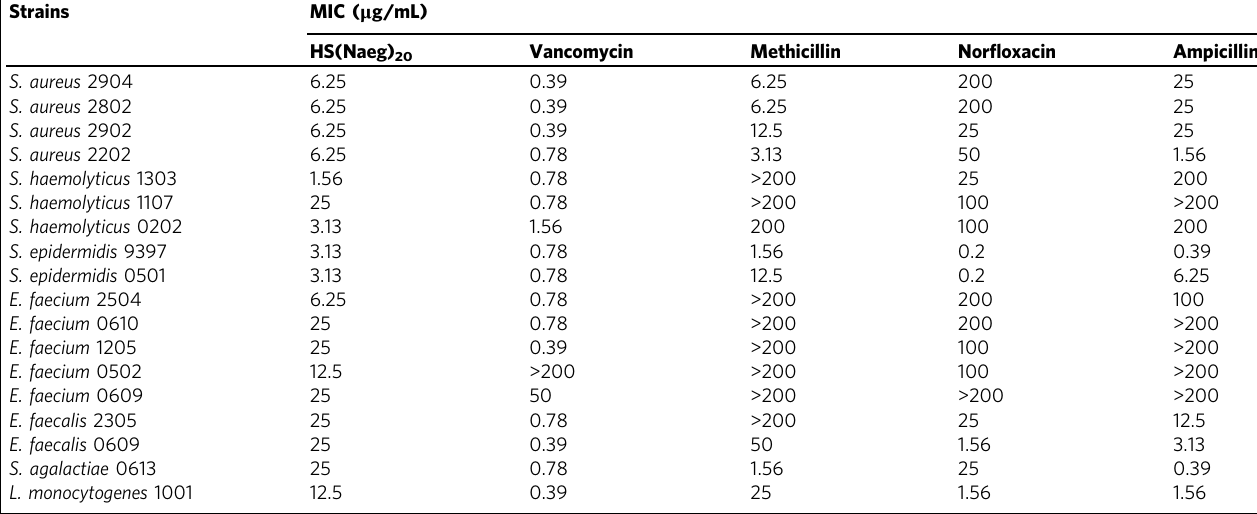
Table 1 Antibacterial activities against clinically isolated Gram-positive strains.